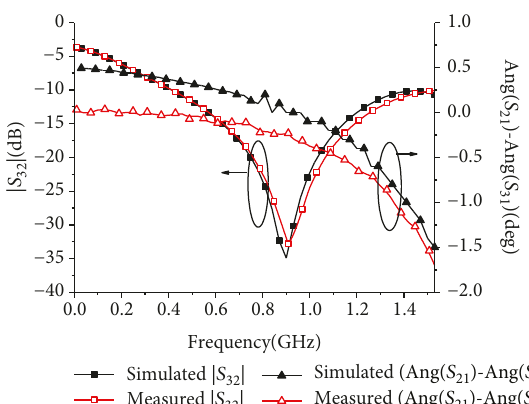
Figure 11: Simulated and measured S